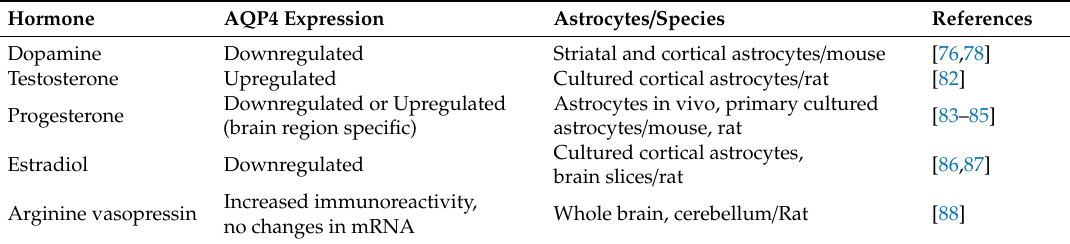
Table 2. Neurotransmitters and hormones a ff ecting AQP4